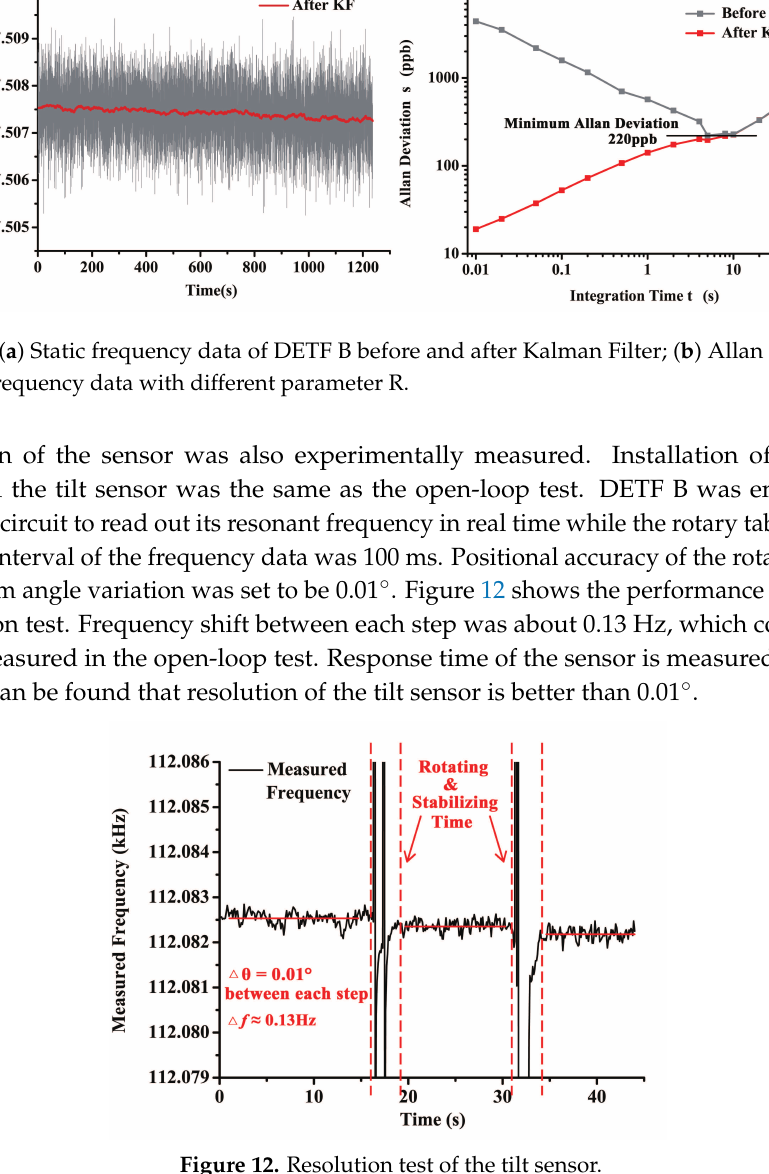
Figure 12. Resolution test of the tilt